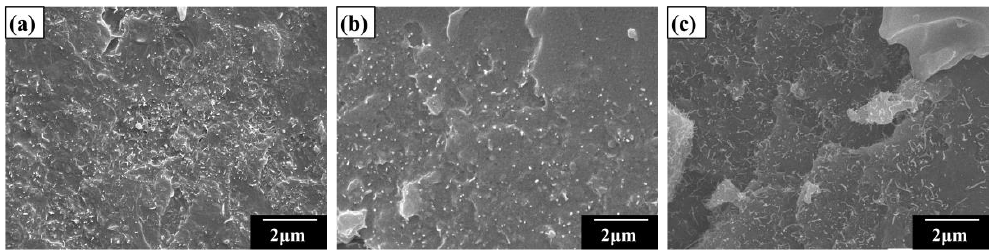
Figure 4. SEM images of the epoxy composites with the MWCNT:GNP ratios of ( a ) 10:0, ( b ) 5:5, and ( c ) 7:3 obtained after the SDS treatments.